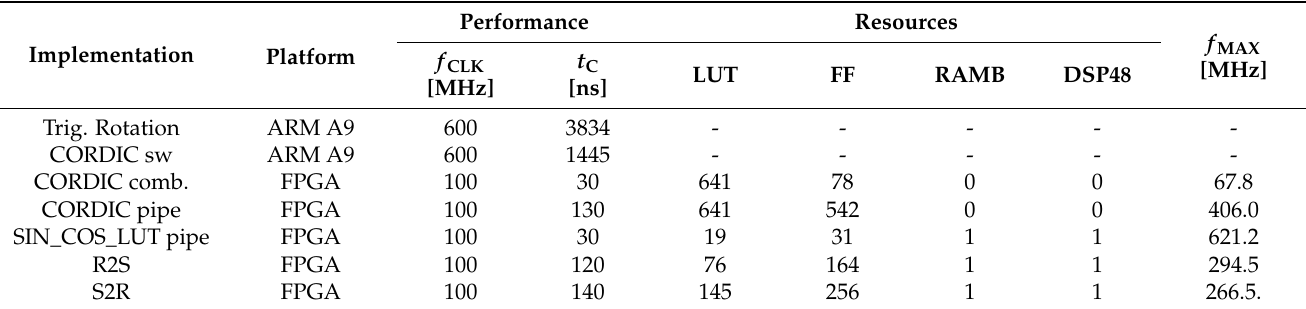
Table 2. Comparison of computation execution time and resource requirements depending on implementation method–programmatic or direct hardware